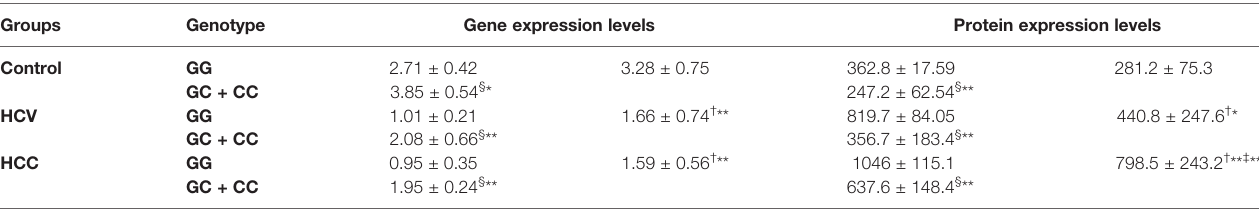
TABLE 6 | Gene and protein expression levels of EpCAM in different genotypes of rs62139665. Groups Genotype